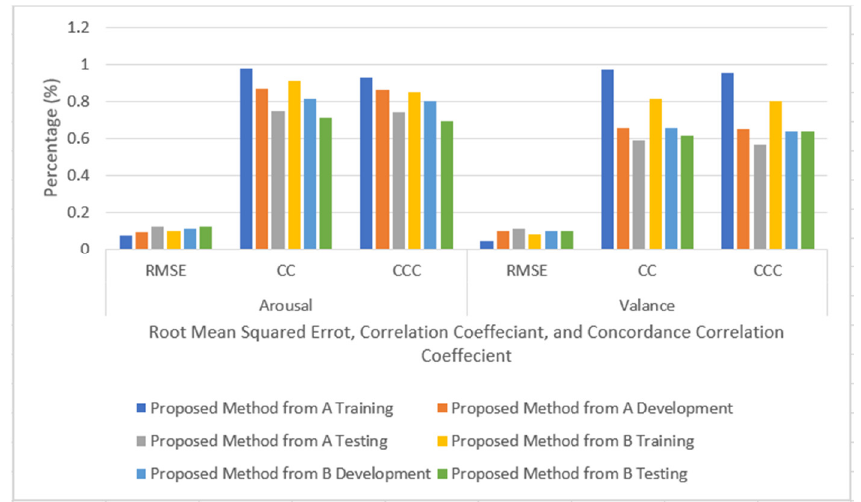
Figure 6. Root Mean Squared Error, Correlation Coefficient, and Concordance Correlation Coeffi- cient.